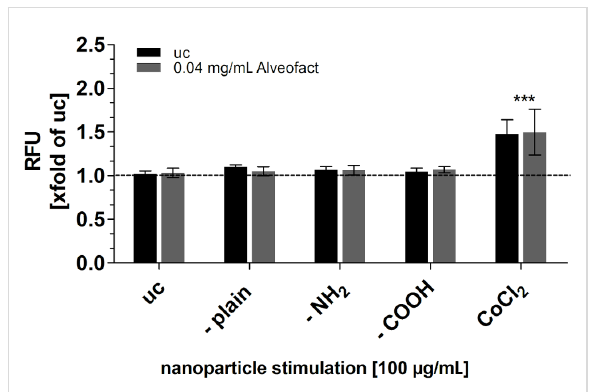
Figure 5: Reactive oxygen species (ROS) production in A549 after stimulation with different aSNPs (–plain, –NH 2 , –COOH; 5–100 µg/mL, untreated control (uc)) in combination with (grey columns) and without (black columns) lung surfactant (Alveofact: 0.04 mg/mL). Fluores- cence intensity of the ROS detection reagent is depicted as relative fluorescence unit (RFU) related to uc. Positiv control: CoCl 2 0.5 mM. Incubation time of aSNPs and CoCl 2 was 20 min, at which no cell loss occurred. Data are depicted as means ± S.D. of 3 independent experi- ments with n = 3. For statistical analysis two-way ANOVA with Bonferroni’s post test was conducted. * P < 0.05, ** P < 0.01 and *** P < 0.001 compared to the untreated